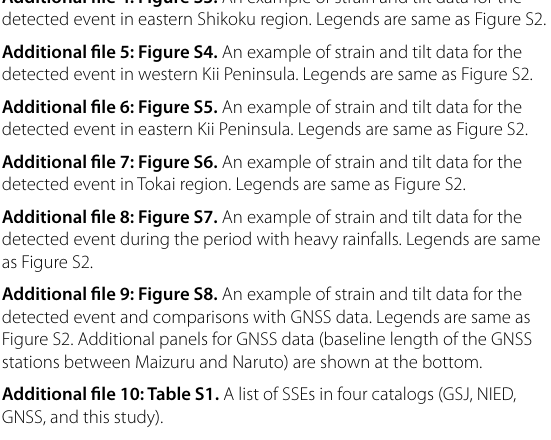
Additional file 10: Table S1. A list of SSEs in four catalogs (GSJ, NIED, GNSS, and this study). Additional file 11: Table S2. Source parameters of SSEs detected in this